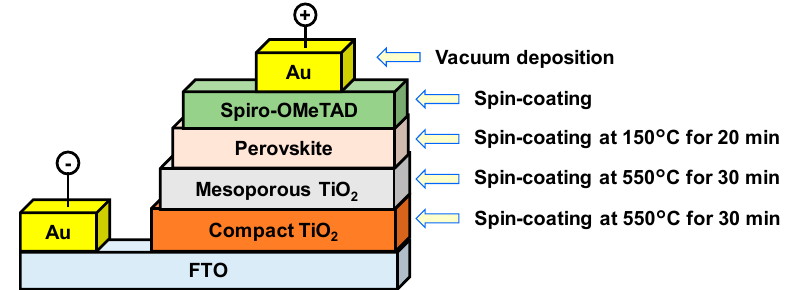
Figure 1. Cross-section of the cell and process conditions.